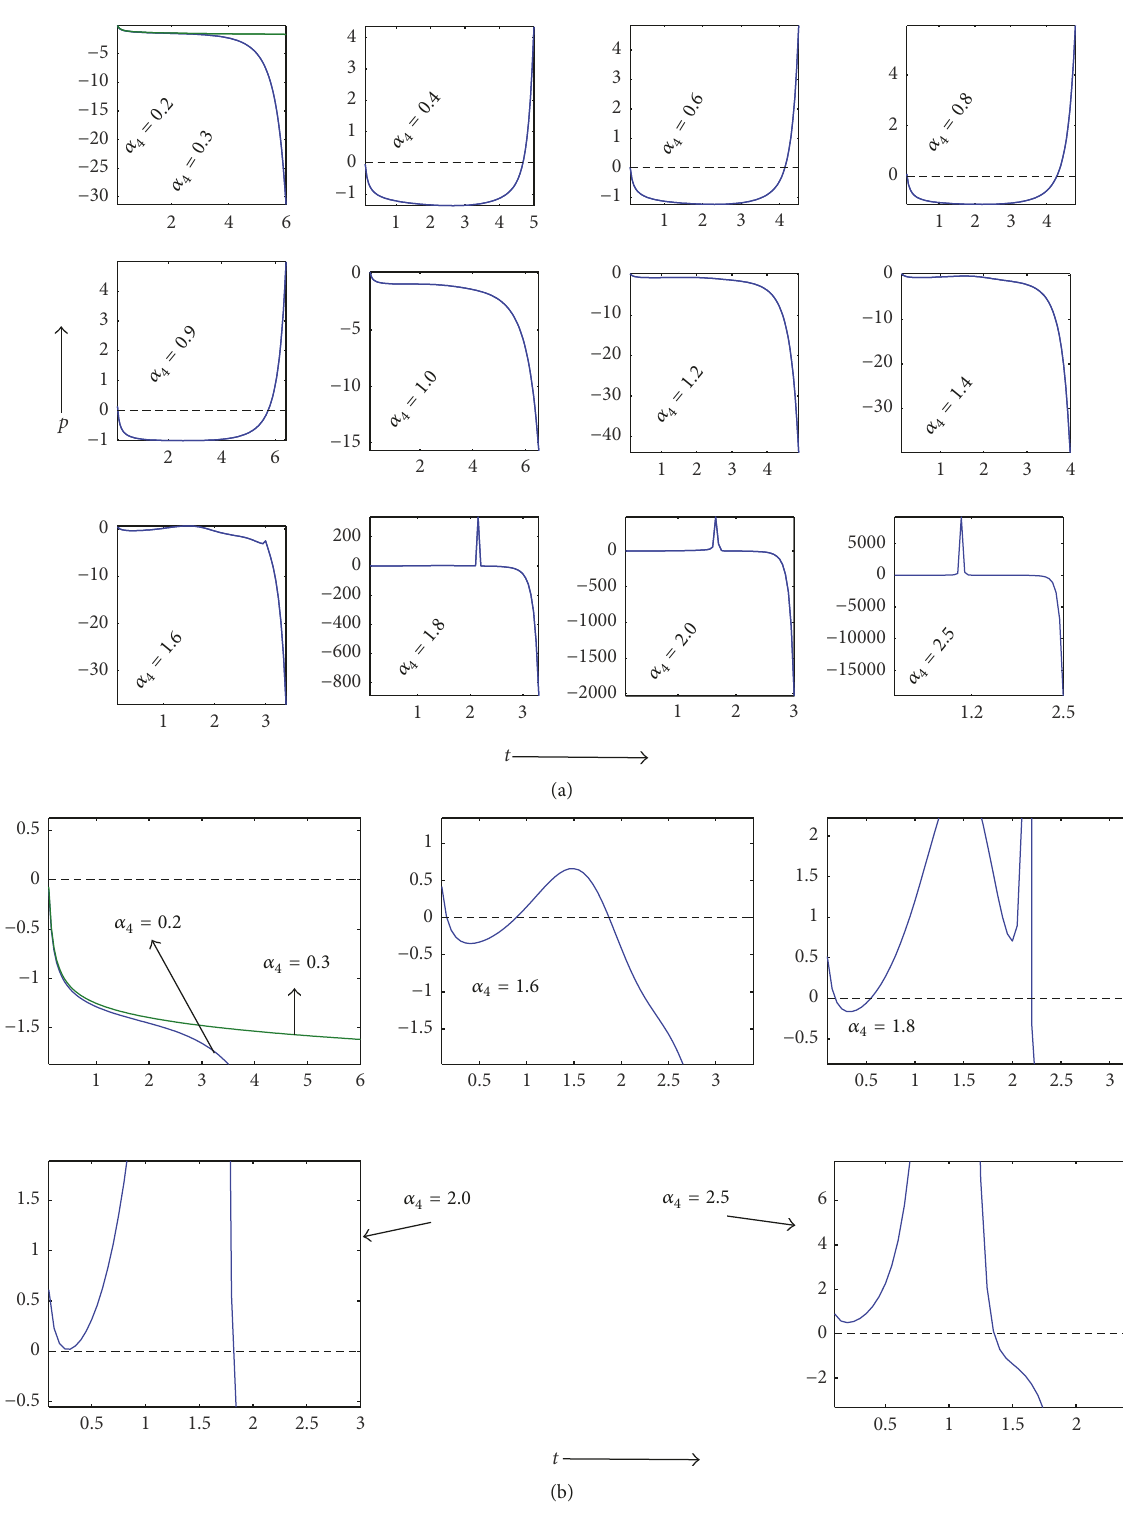
Figure 15: Variation of pressure 𝑝 against time for 𝛼 1 = 0.5 , 𝛼 5 = 0.3 , 𝐴 = 𝐵 = 1 , 𝑛 = 0.1 , 𝜔 = 1 , 𝜙 0 = 1 , 𝑐 2 = 0.1 , and different 𝛼 4 . (b) shows the zooming of